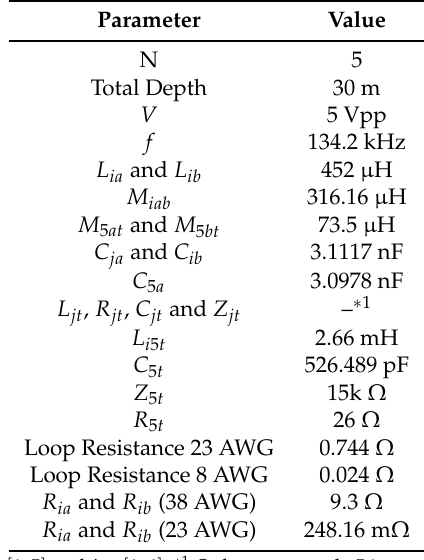
Table 1. Experiment Setup for Parasitic Resistance Evaluation in the Last Sensor Node.